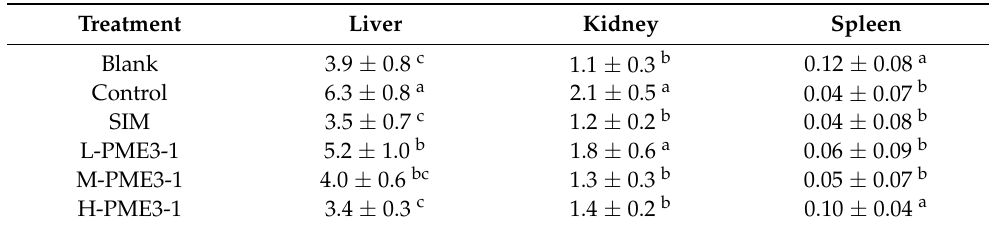
Table 2. Effects of PME3-1 on the relative organ weights of hamsters fed with high fat and choles- terol